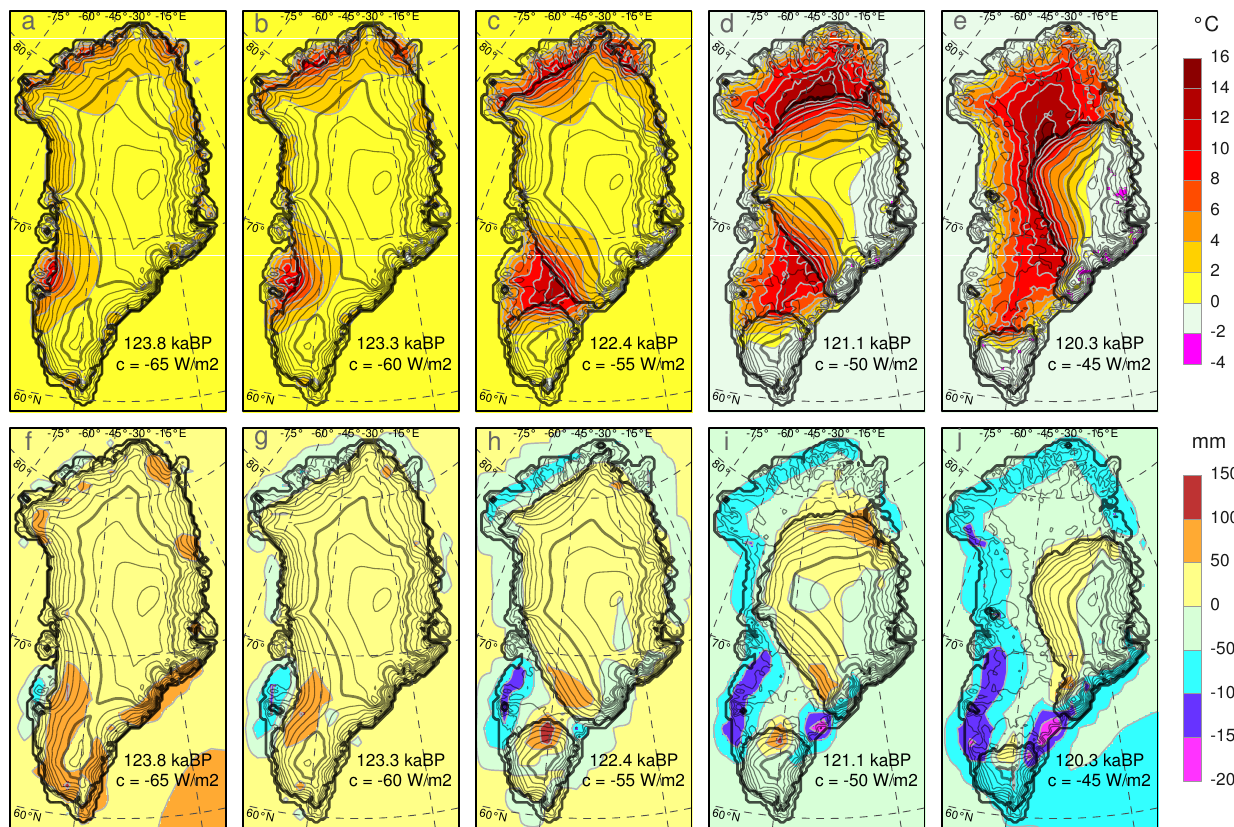
Fig. 5. (a–e) Precipitation-weighted annual temperature anomaly and (f–j) the change in annual precipitation relative to present day, at the Eemian minimum extent for each of the five simulations in Fig.